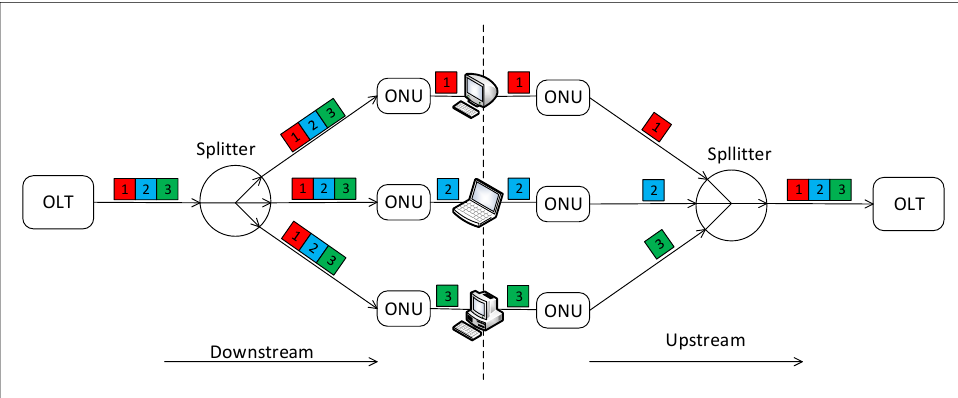
Figure 3. Principle of TDM in a